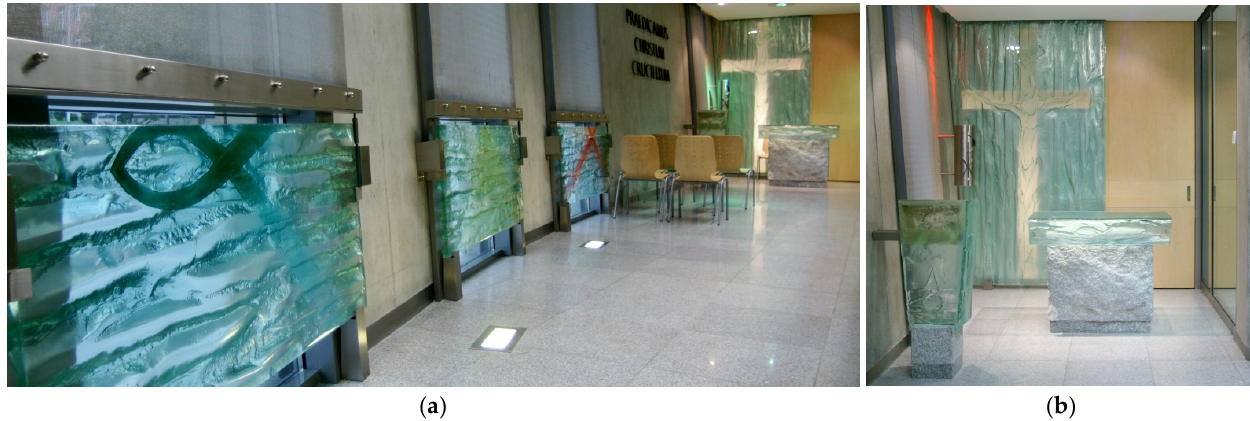
Figure 19. The subdued interior design of the chapel with glass compositions: ( a ) glass panels introducing color through three Christian symbols; ( b ) glass elements of liturgical furniture and interior design (Tomasz Urbanowicz).